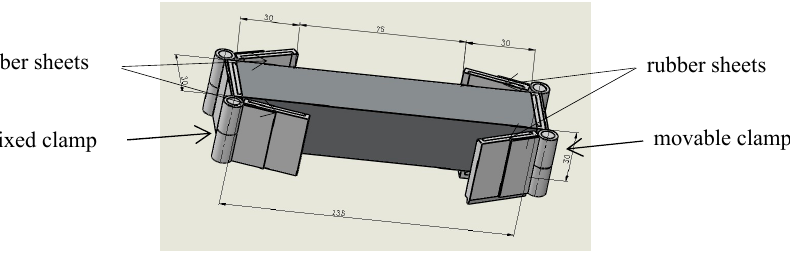
Figure 5. Schematic drawing of the two specimen clamps (units for the numbers: mm).